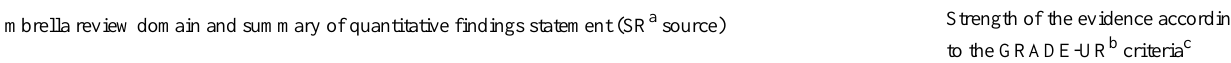
Table 1. Summary of quantitative umbrella review findings and Grading of Strength of Evidence for Quantitative Research at the Level of an Umbrella Review evaluation of quantitative